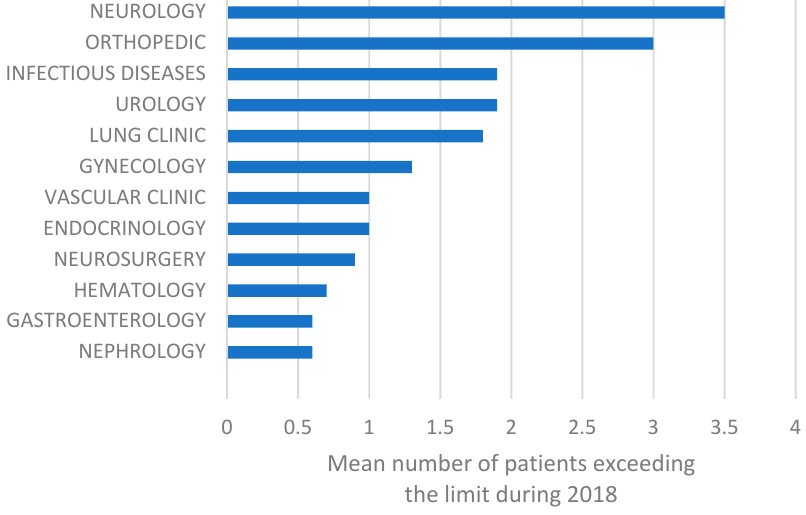
Overcrowdedness was not equally distributed among the included clinics (Figure 2). Only four clinics had overcrowdedness values below one (1), and these were the nephrology, hematology, neurosurgery and gastroenterology clinics.